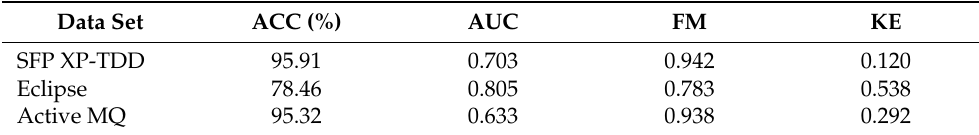
Table 11. RNNBDL Algorithm Based Classification results for All Data set. Data Set ACC (%) AUC FM SFP XP-TDD